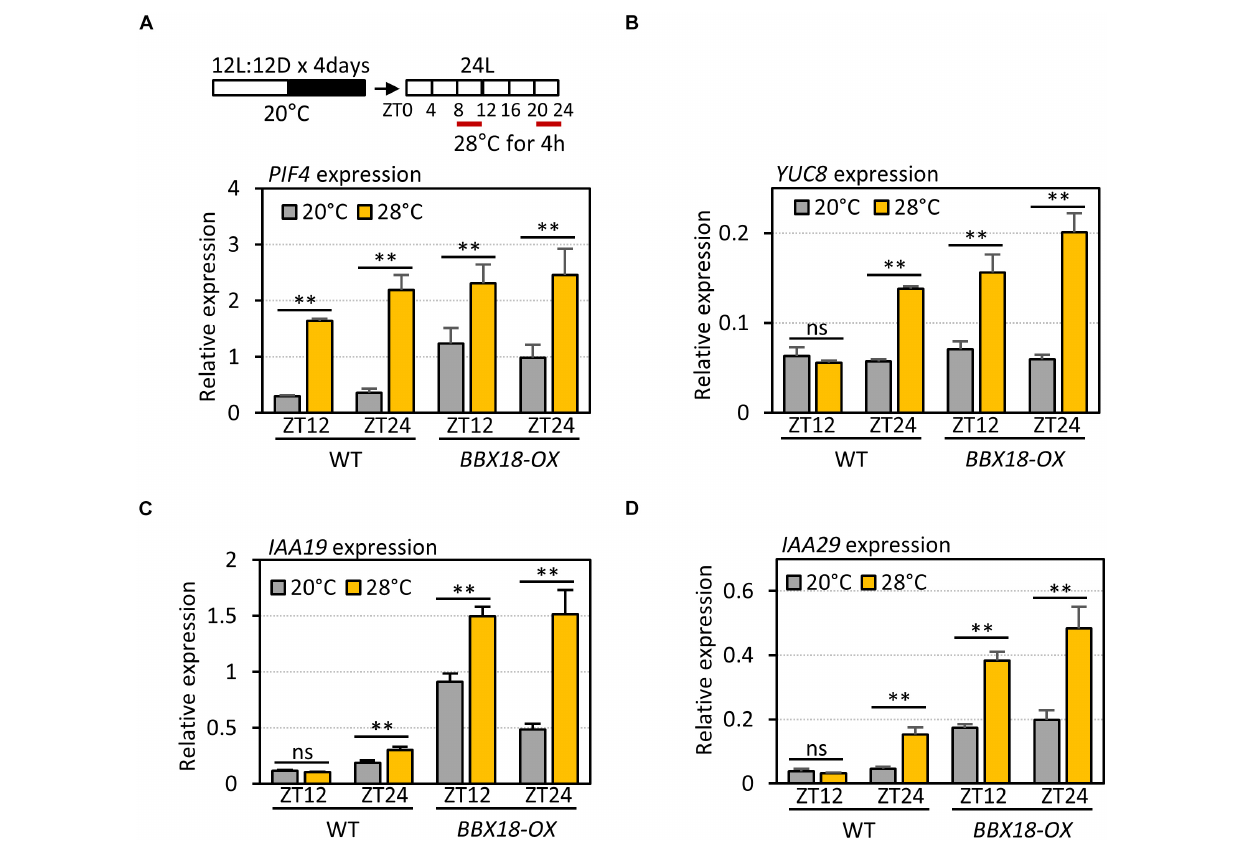
FIGURE 6 | Overexpression of BBX18 restores thermosensitivity in the evening. qRT–PCR analysis to check the expression of PIF4 (A) , YUC8 (B) , IAA19 (C) , and IAA29 (D) . WT and BBX18-OX plants were grown in 12 h light/12 h dark cycles (12L:12D) at 20 ◦ C for 4 days. On the 5th day, the plants were shifted to continuous white light and exposed to a high temperature (28 ◦ C) for 4 h at different ZTs (ZT8–12 and ZT20–24) before harvesting for RNA extraction. The expression of target genes was normalized to that of PP2A . Error bars indicate SD ( n = 3). ∗ P < 0.05 and ∗∗ P < 0.01 (Student’s t -test). ns, not significant (Student’s t -test P ≥